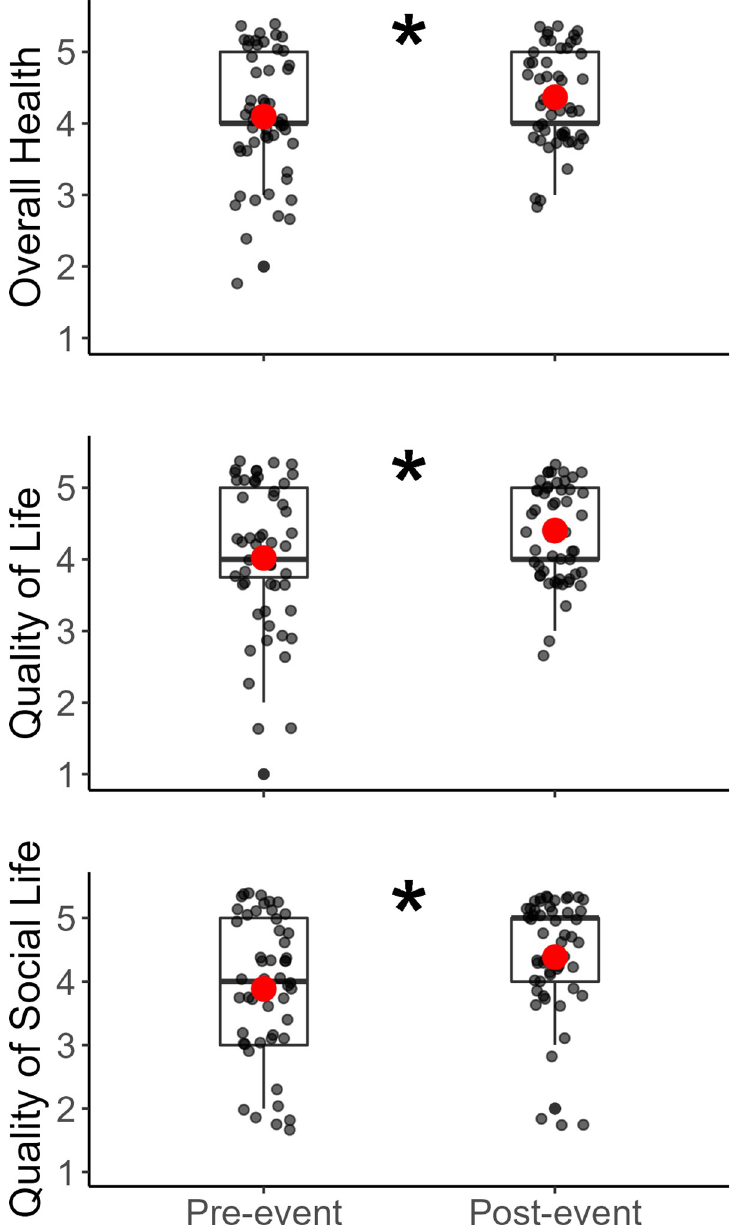
Fig 3. Pre- and post-scores on the acute influence of participation in the Heroes on the Hudson event on Overall Health, QoL, and QoSL. QoL: Quality of Life. QoSL: Quality of Social Life. Asterisks represent significant differences between pre- and post-survey results. Points show individual participant data, jittered for clarity. Red dots represent means.